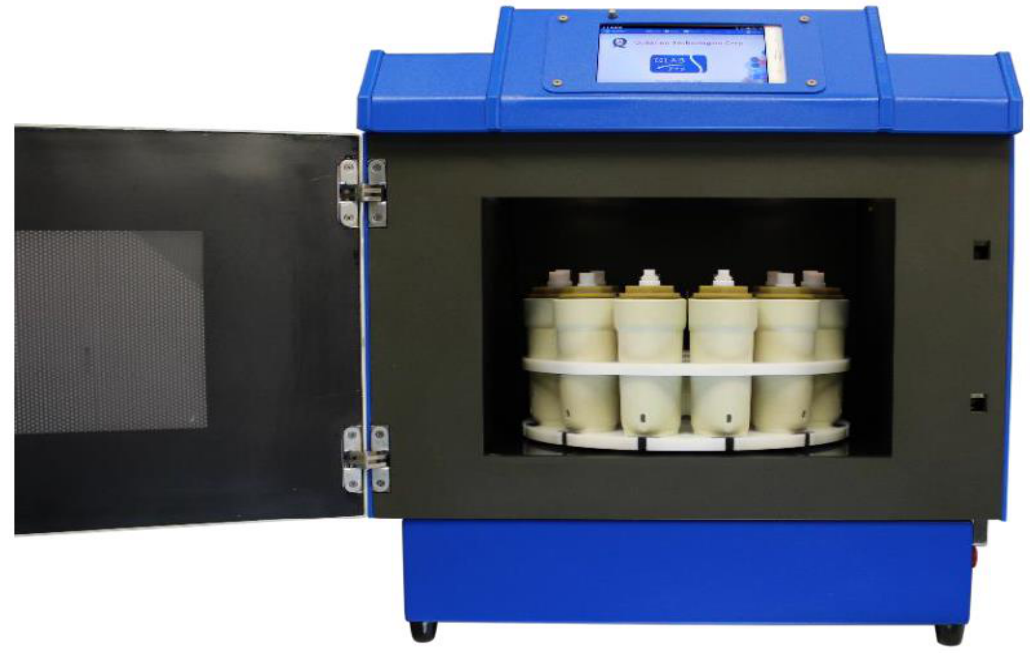
Figure 1. The QLab pro microwave digestion system.